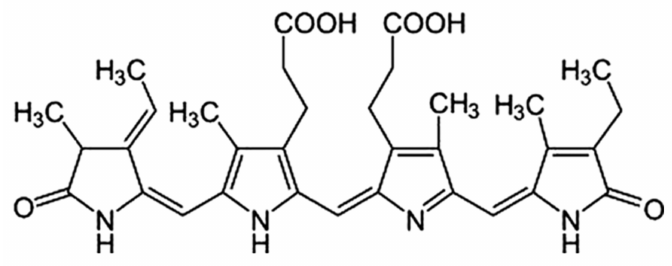
Figure 1. Chemical structure of